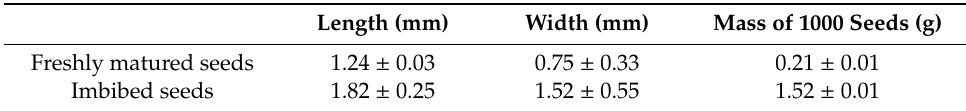
Table 1. Comparison of the length, width, and 1000-seed mass of freshly matured and imbibed Lepidium apetalum seeds (mean ± se). Length (mm) Width (mm) Mass of 1000 Seeds (g) Freshly matured seeds 1.24 ± 0.03 1.52 ± 0.01